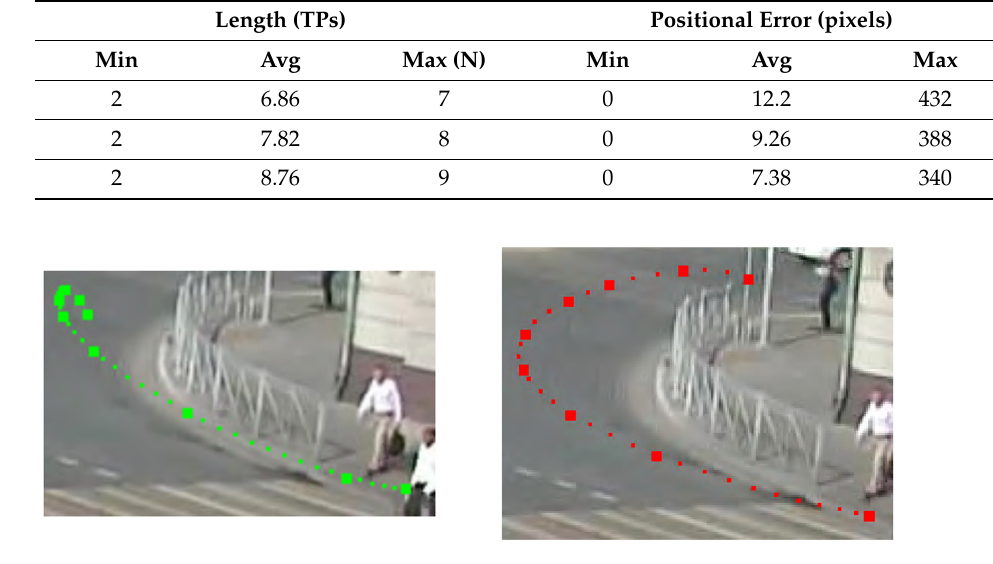
Figure 10. Trajectory approximation using RDP N. Table 2. Length and positional errors for trajectories, approximated with RDP N.